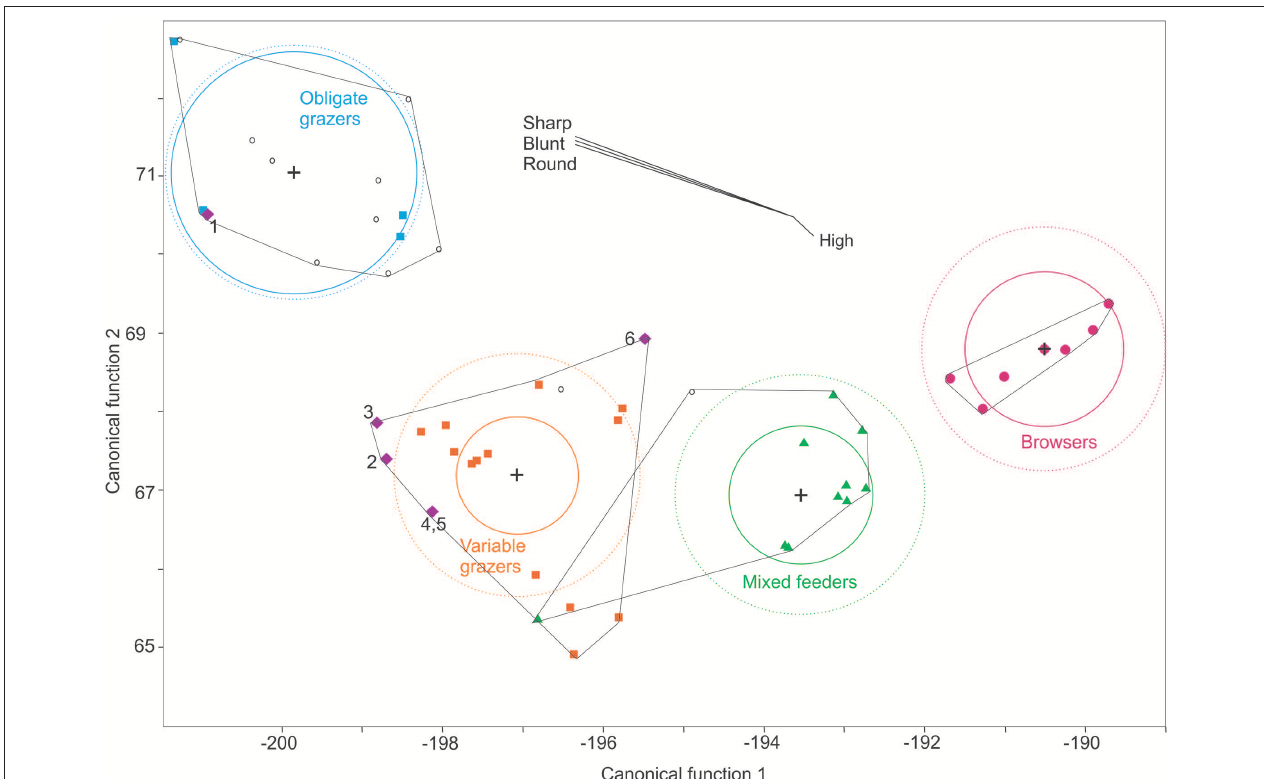
FIGURE 7 | Canonical plot of the discriminant analysis of the mesowear data used in this paper. Chiapas: 1. Equus conversidens , 3. Haringtonippus francisci , 6. E. mexicanus . Oaxaca: 2. E. conversidens , 4. H. francisci , 5. E. mexicanus . Obligate grazers, blue squares; variable grazers, orange squares; mixed feeders, green triangles; browsers, fuchsia dots. Open circles are the Equus species from central and northern Mexico. Crosses show the centroid of each dietary group. In each dietary category, the inner circle represents the 95% confident region that contain the true mean of the group; the exterior dotted circle represents the region estimated to contain the 50% of the population for that group. The biplot lines (High, Sharp, Blunt, Round) indicate the coordinate directions in canonical space. Convex hulls for each diet category are outlined. Canonical function 1 explains 84.88% of the variation and canonical function 2 explains 14.99%.